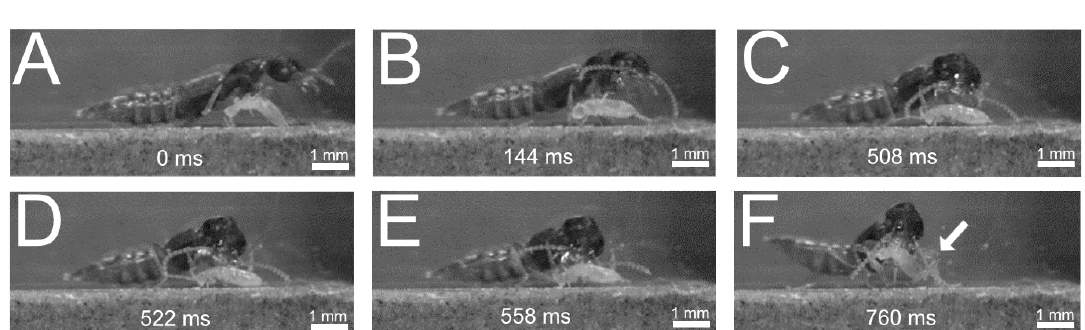
Figure 17. Rugilus rufipes . Direct seizure with the mandibles (lateral aspect). Time course of depicted sequence is provided in milliseconds elapsed from the start (= image A ). Images B – F depicting the process of prey capture. For further description, see text. Arrow in F points to front leg. Source: [47].